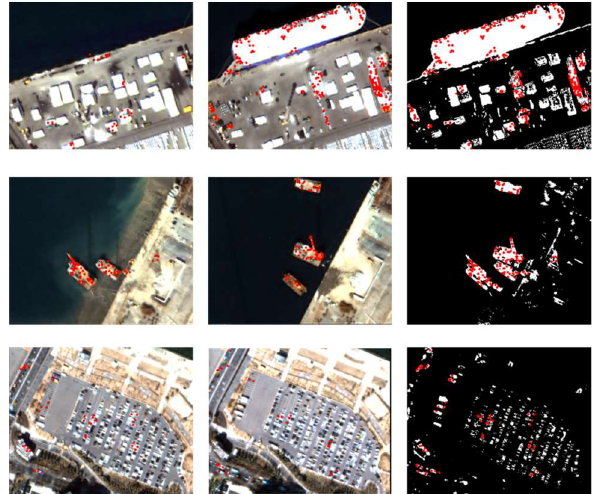
Figure 7. Result of small object change areas (red point) processed per feature. (Left: before image, Middle: after image, Right: Result